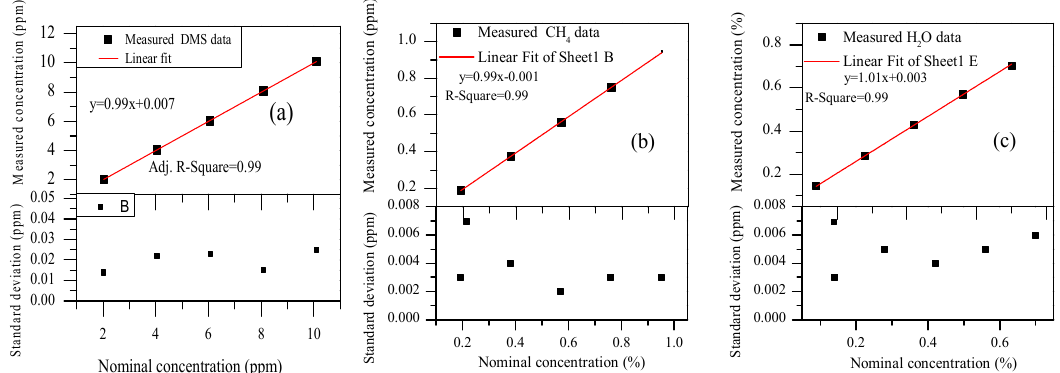
Figure 7. ( a ) The concentration of CH 4 and H 2 O remained at 0.95 ppm and 0.7%, respectively, while the concentration of DMS ranged from 2.02 ppm to 10.1 ppm (in 2.02 ppm intervals) in the first group, and the standard deviations between nominal concentration and measured concentration are presented; and ( b , c ) the volume of DMS remained at 10.1 ppm, the concentration of CH 4 ranged from 0.19 ppm to 0.95 ppm (in 0.19 ppm intervals) while the concentration of H 2 O ranged from 0.14% to 0.7 % (in 0.14% intervals) in the second group, and the standard deviations between nominal concentration and measured concentration are presented.